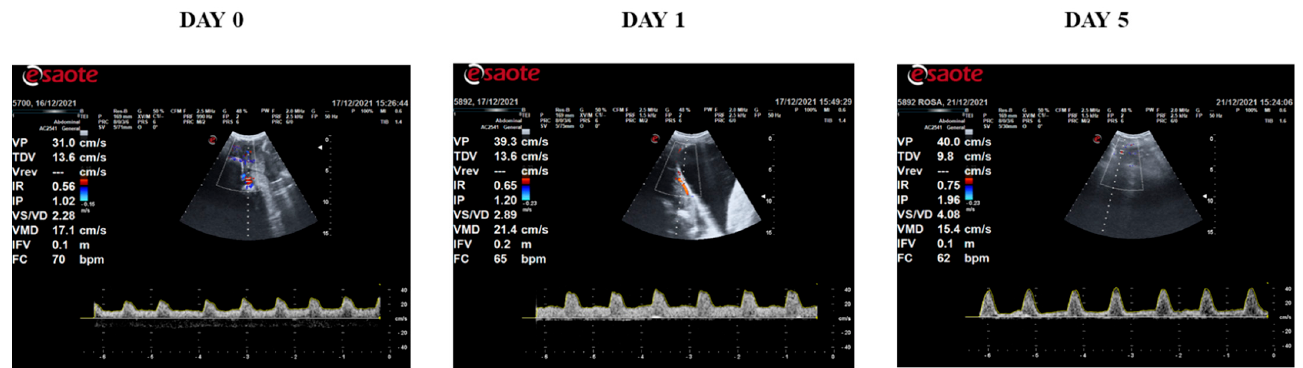
Figure 2. Box plot describing Doppler ultrasonography values of the uterine arteries’ blood flow at the three days of evaluation (D0, D1, and D5). Significant differences between experimental groups are indicated as ## ( p < 0.01) and ### ( p < 0.001). Small circles (°) and asterisks (*) in the box plot represent outliers and extreme cases, respectively.